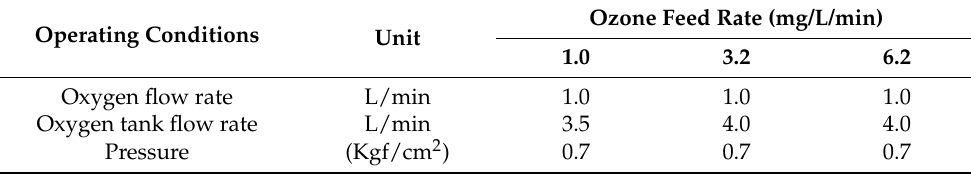
Table 1. Operational conditions.